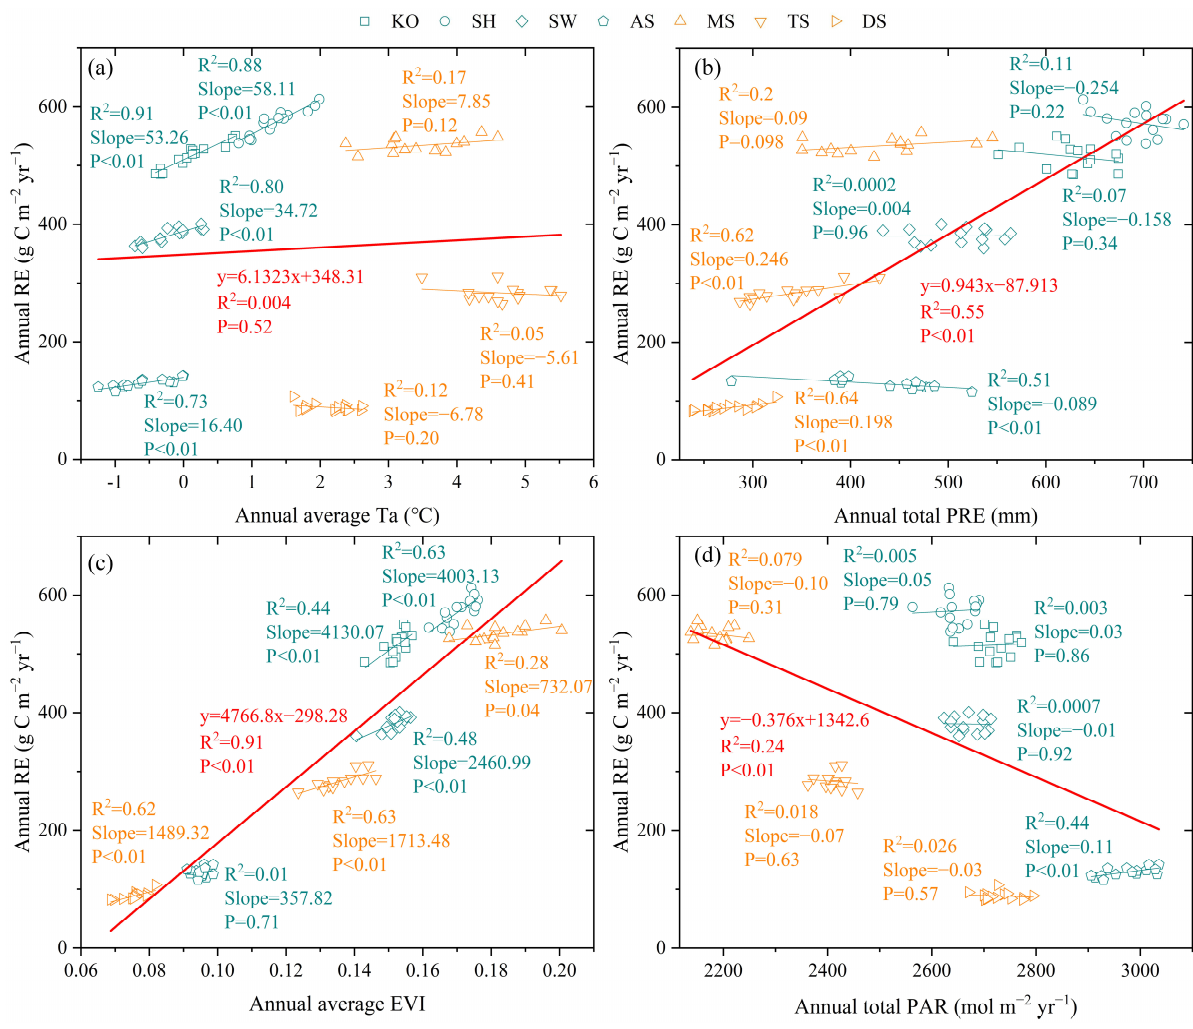
Figure 8. Interannual dynamic correlation between annual RE and ( a ) annual average Ta, ( b ) annual total PRE, ( c ) annual average EVI, and ( d ) annual total PAR from 2001–2015 in alpine and temperate grasslands. The dark cyan fitted lines refer to the fit lines for the alpine grassland subtypes, and the orange lines refer to the fit lines for the temperate grassland subtypes. The red lines refer to the fit lines across all seven grassland subtypes.